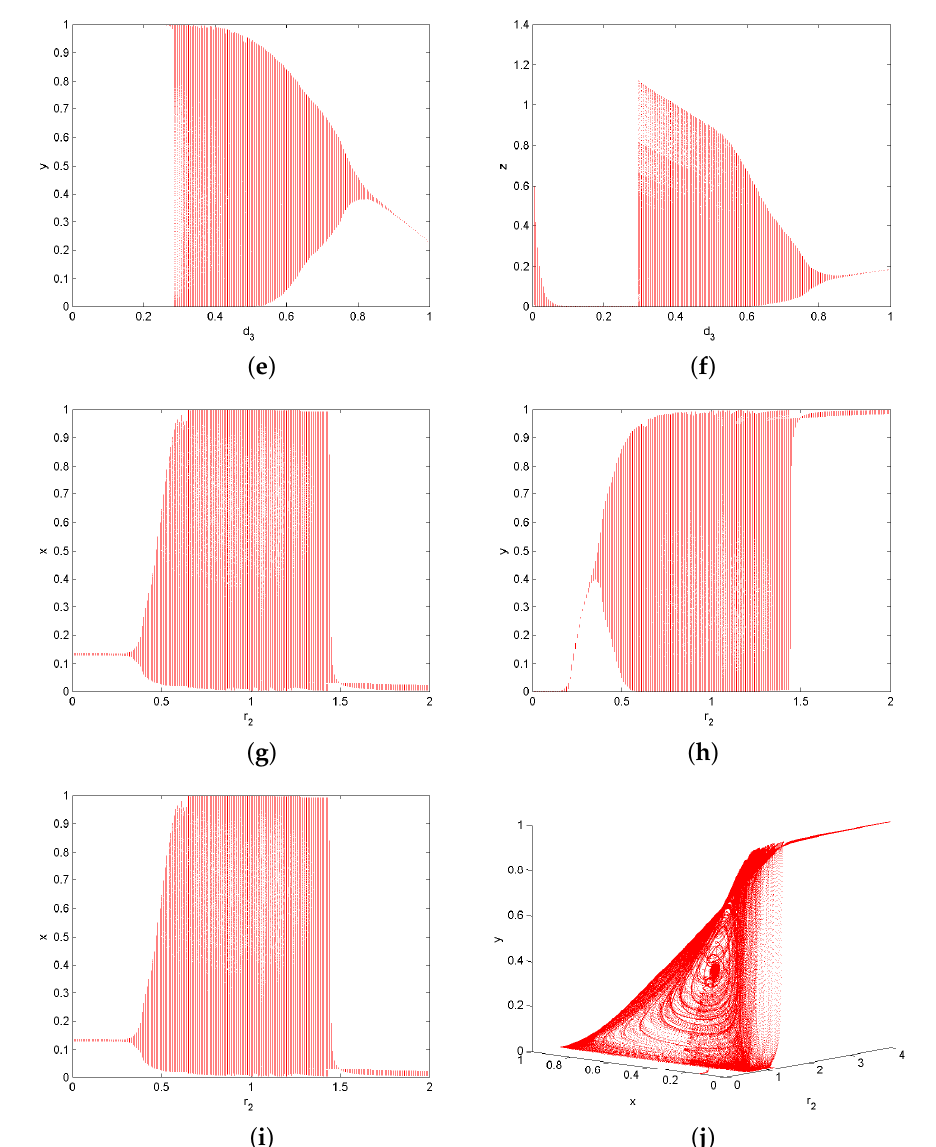
Figure 13. Bifurcations diagrams of system (4) with the parameters given in (18) and h = 0.1. ( a ) The a 12 − x plane; ( b ) the a 12 − y plane; ( c ) the a 12 − z plane; ( d ) the d 3 − x plane; ( e ) the d 3 − y plane; ( f ) the d 3 − z plane; ( g ) the r 2 − x plane; ( h ) the r 2 − y plane; ( i ) the r 2 − z plane; ( j ) the ( r 2 , x , y )